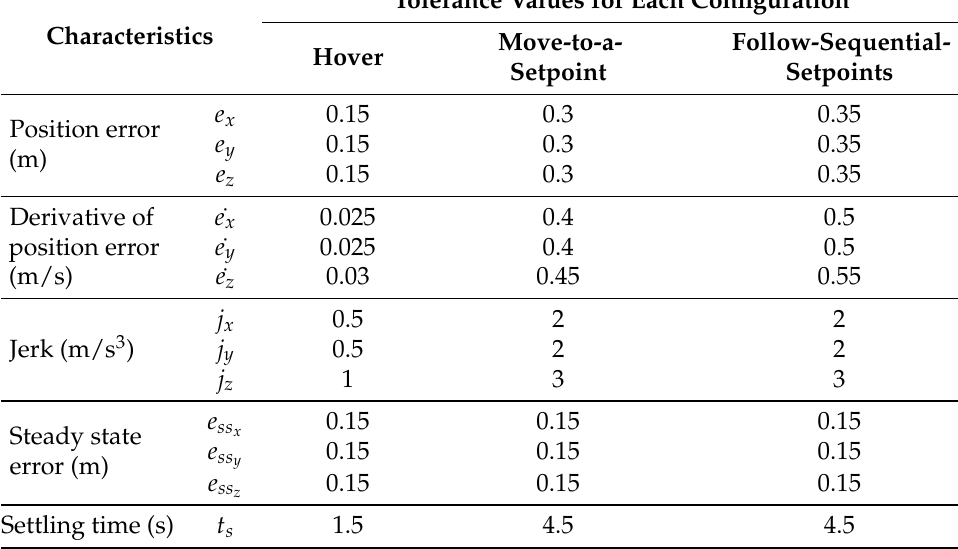
Table 1. Initial tolerance values for a stable